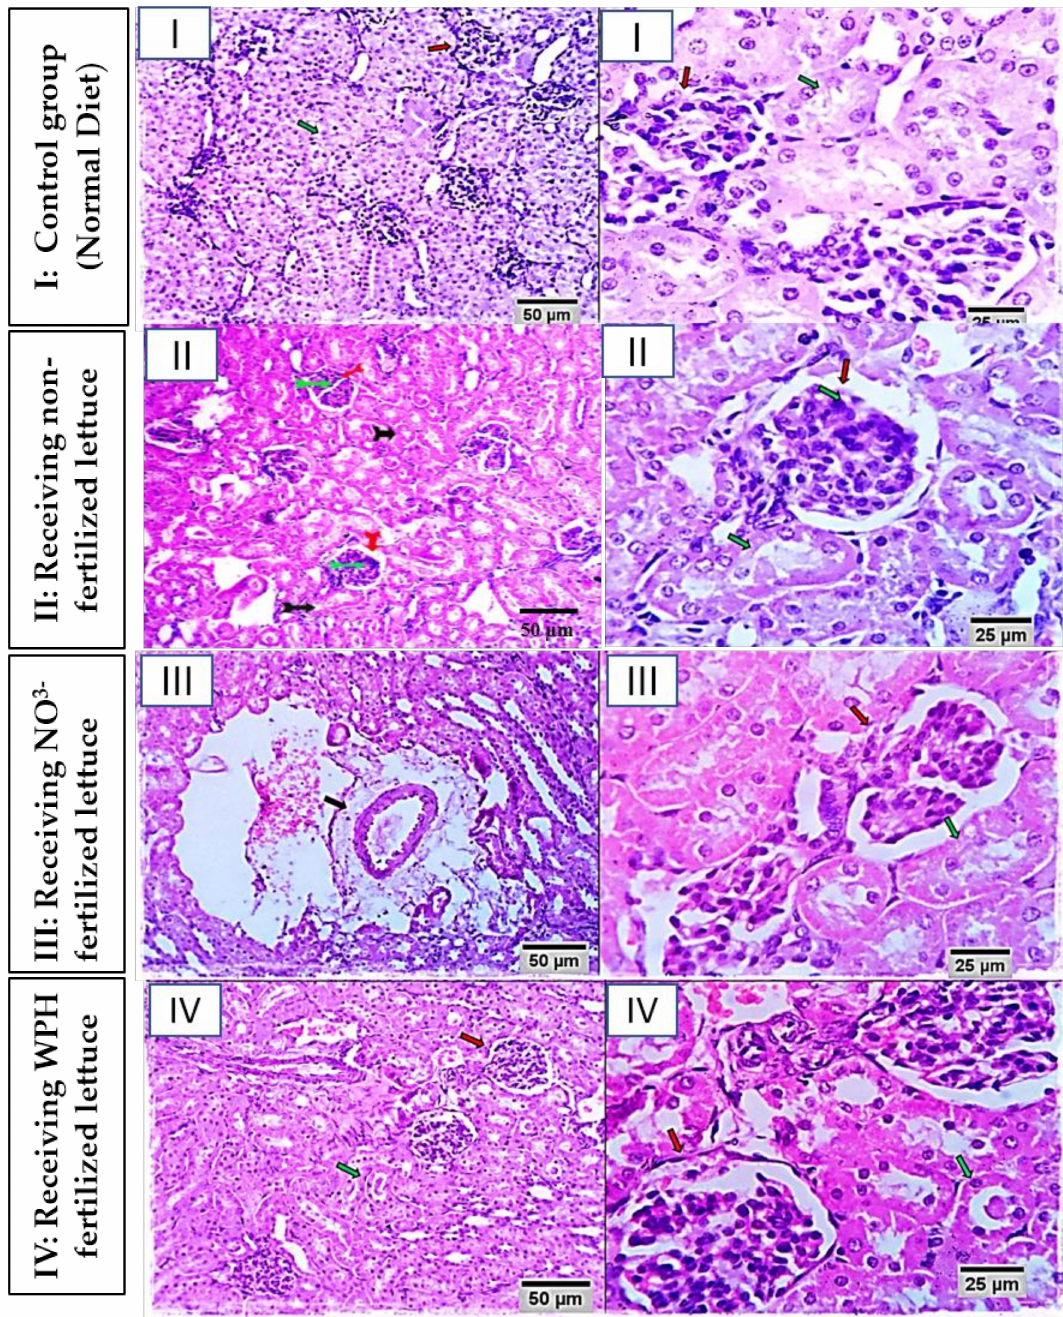
Figure 2. Photomicrographs from kidney of different rabbit groups (I, II, III, and IV) at 25 µ m and 50 µ m scale bars. Kidney sections of group I show normal cortical and medullary counterparts. Glomeruli, proximal, distal, and collecting tubules are normal (red and green arrows). Group II kidney tissues show normal nephron structural unites with preserved glomerular and tubular counterparts (red and green arrows). Group III kidney sections show moderate congestion of renal blood vessels and capillaries, marked perivascular edema, hemorrhages (black and blue arrows), and lobulated and partially atrophied glomeruli (red arrow). Some tubular epithelia appear degenerated, mostly cloudy swelling and hydropic degeneration (green arrow). Scale bars 50 µ m and 25 µ m for the images of liver and kidney sections, respectively. Group IV is showing lesions represented by mild congestion of the renal blood vessels (yellow arrow). Some renal tubules show mild cystic dilatation with atrophied epithelial lining, and others show intratubular hyaline casts (green arrows). A few glomeruli appear lobulated (black arrow). Scale bars 50 µ m and 25 µ m for images of liver and kidney sections,